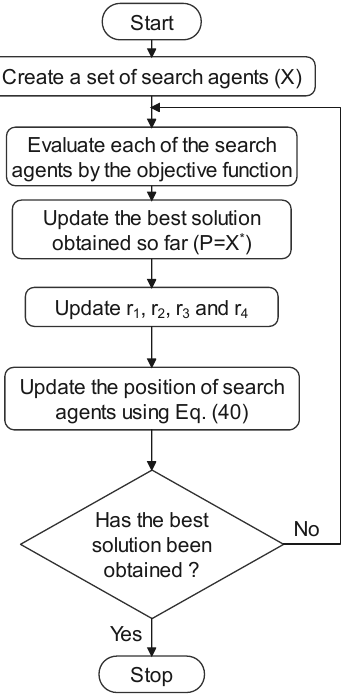
Figure 9. Flow chart diagram of Sine Cosine algorithm. Equations (38) and (39) are used for position updating. X t solution in the t th iteration and i th dimension. r 1 , r 2 , and r 3 are random numbers [42]. P i